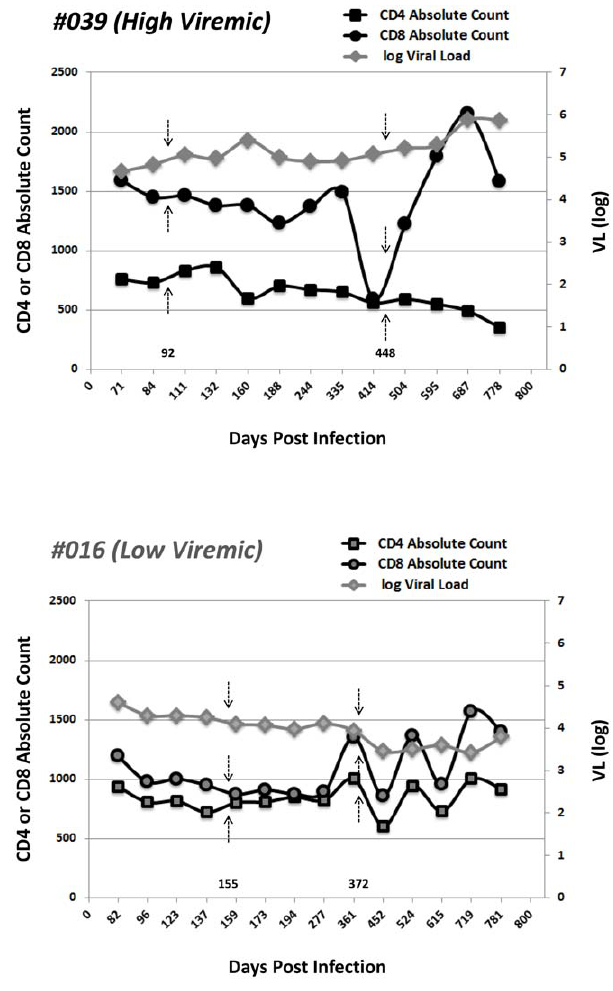
Figure 1. Viral load, CD4 + and CD8 + T-cell counts (n=2). Viral load (triangles; 46731 and 41023 viral RNA copy/ml of plasma), absolute CD4 + T-cell count (squares) and absolute CD8 + T-cell count (circles) are shown for two time points. The grey arrows show the time points in which the virus was sequences and the black arrows indicate the time points in which the leukapheresis blood was taken and PBMCs were used in this study.